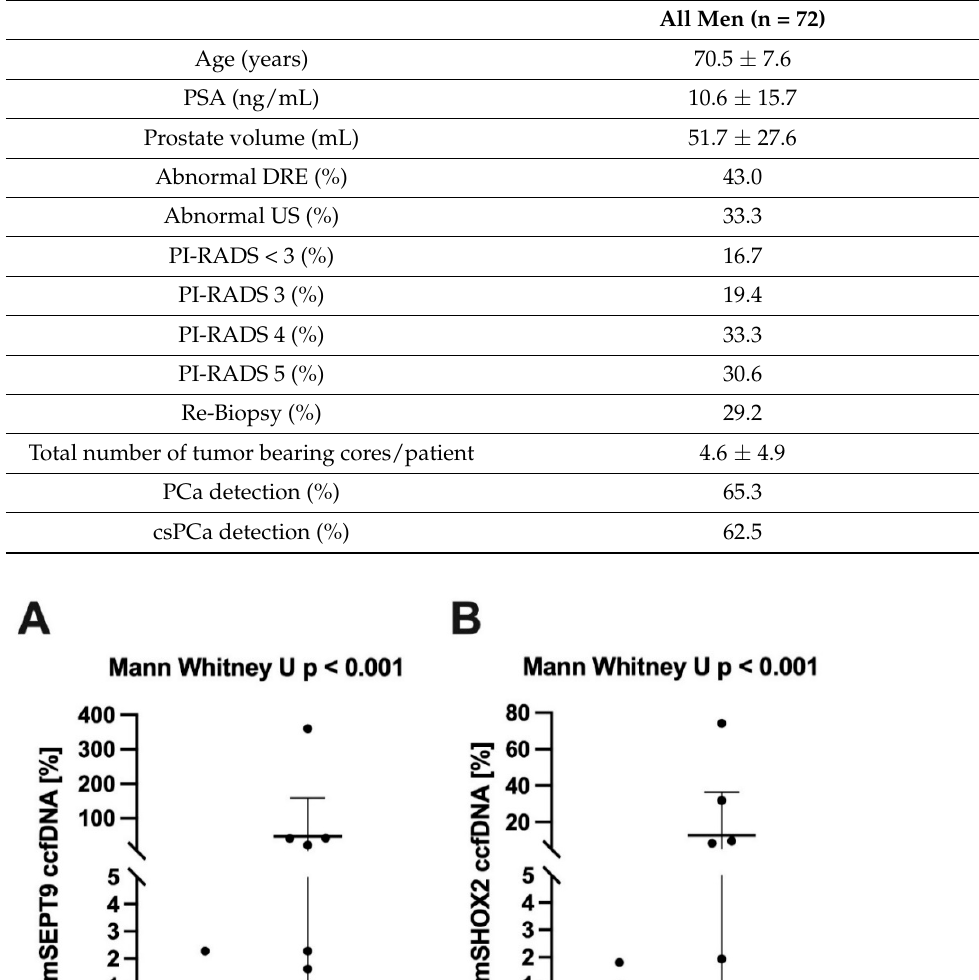
Table 1. Descriptive statistics of University Hospital Bonn Biopsy Cohort.